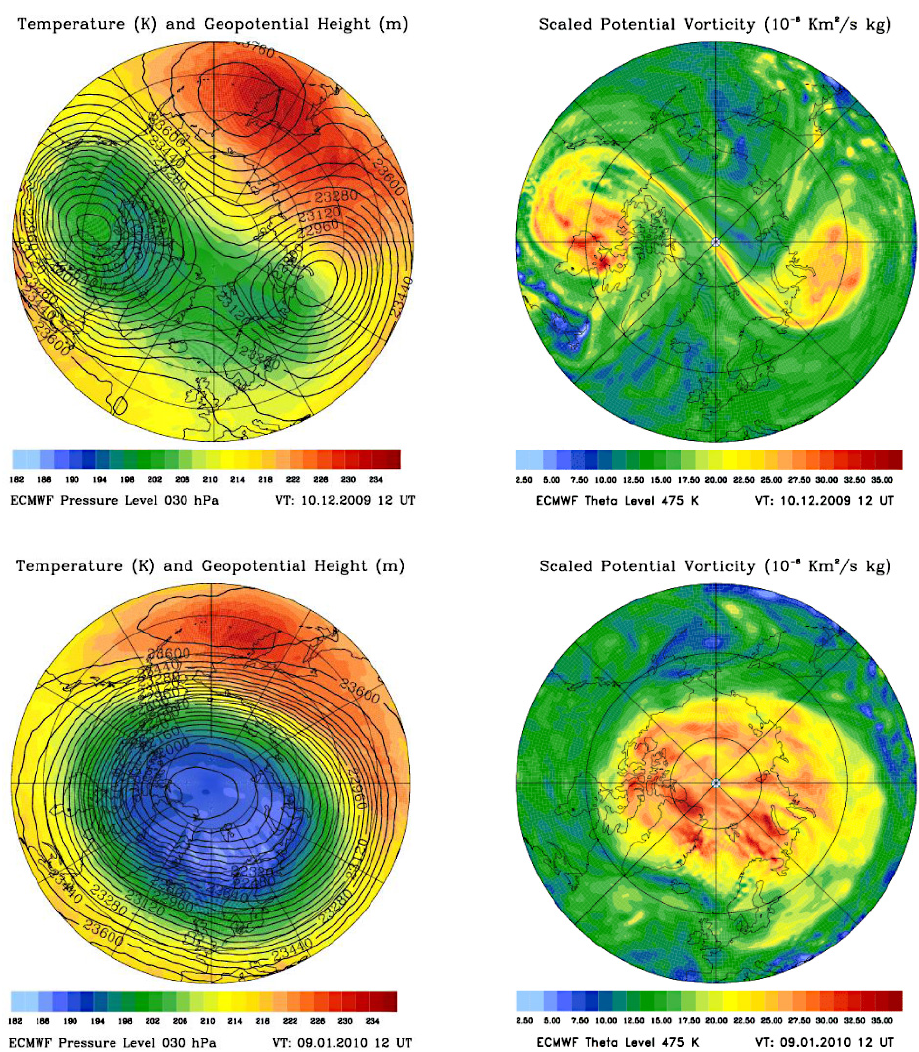
Fig. 5. Left: Absolute Temperature (K, colour shaded) and geopotential height (m; black contour lines) at the 30hPa pressure surface. Right: Scaled or modified potential vorticity PV · (2 /420K) − 9 / 2 (PVU; colour shaded) at 2 = 475K. Operational ECMWF T1279/L91 analyses interpolated at a regular 0.5 ◦ × 0.5 ◦ latitude/longitude